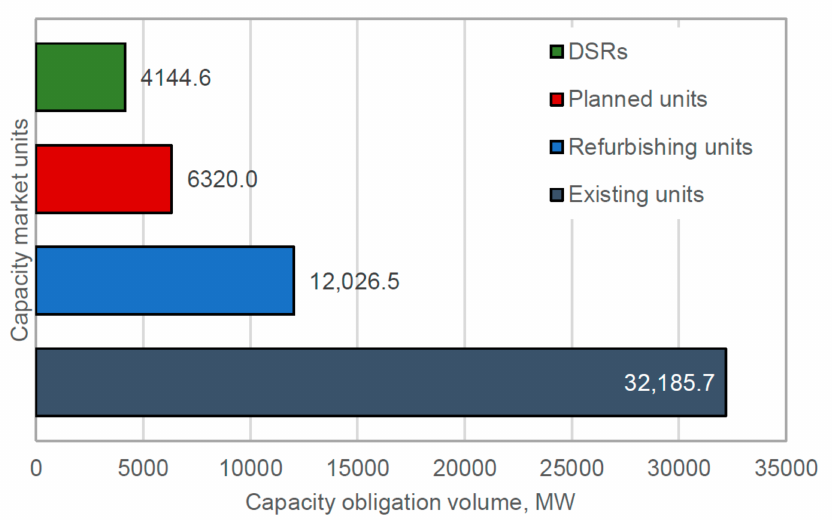
Figure 14. Capacity obligation volume contracted in main capacity auction for 2021–2025 delivery years; break down by official (declared) assignments to capacity market units. Source: Own analysis based on [37–41].